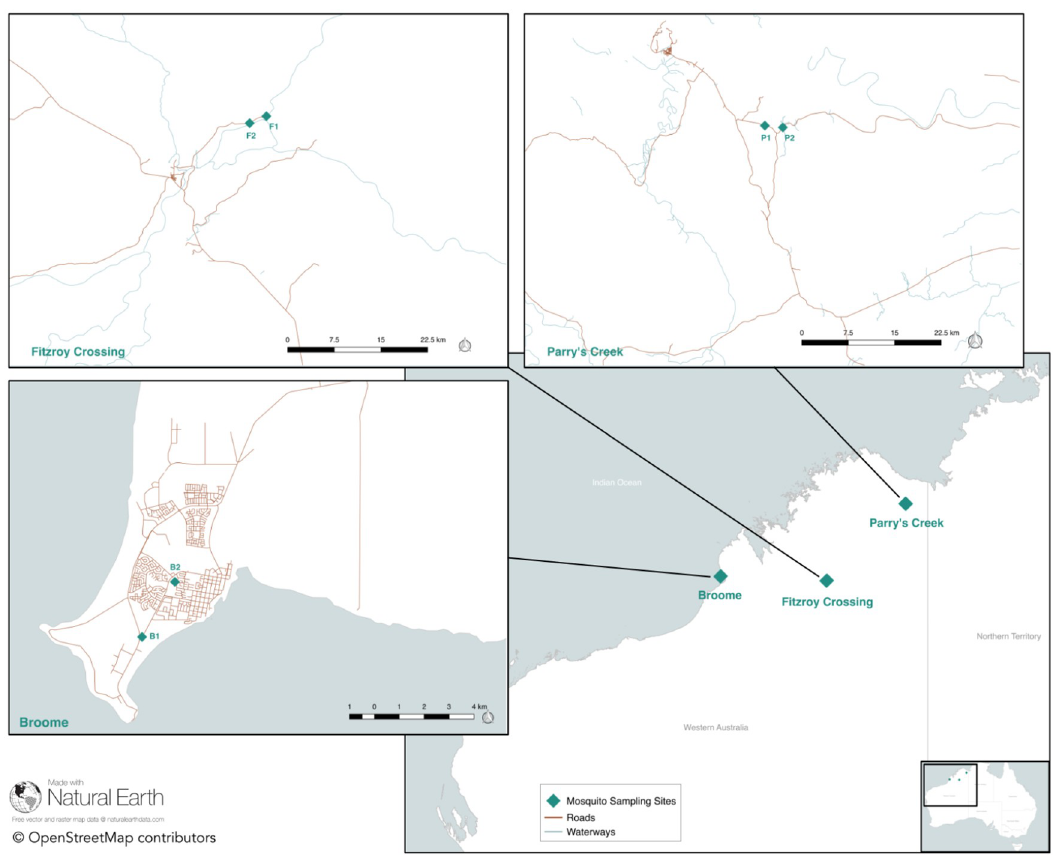
Fig 1. Map of northern Western Australia. Mosquito trap locations for three sites are marked with a green triangle. The inset maps indicate the locations of each of two traps located at each site. Map prepared using QGIS v2.18.15 (http://qgis.osgeo.org), OpenStreetMap, Natural Earth, and Mainroads Western Australia (https://portal-mainroads.opendata.arcgis.com/). The baselayer shapefile was obtained from the Australian Government data portal